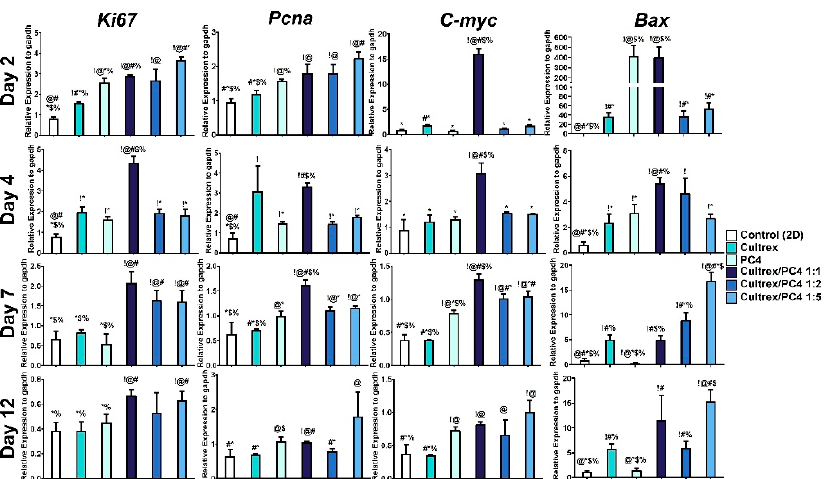
Figure 4. Gene expression of cell proliferation markers ( Ki-67, Pcna, c-myc , and Bax ). After HepG2 cells were cultured in different conditions from day 2 to 12, the mRNA expression profile was determined by qPCR. ! indicates groups compared with control (2D). @ indicates groups compared with Cultrex. # Indicates groups compared with PC4. * indicates groups compared with Cultrex/PC4 1:1. $ indicates groups compared with Cultrex/PC4 1:2. % indicates groups compared with Cultrex/PC4 1:5. The results from the three independent experiments are presented as the mean ± standard deviation. !, @, #, *, $, % p < 0.05.